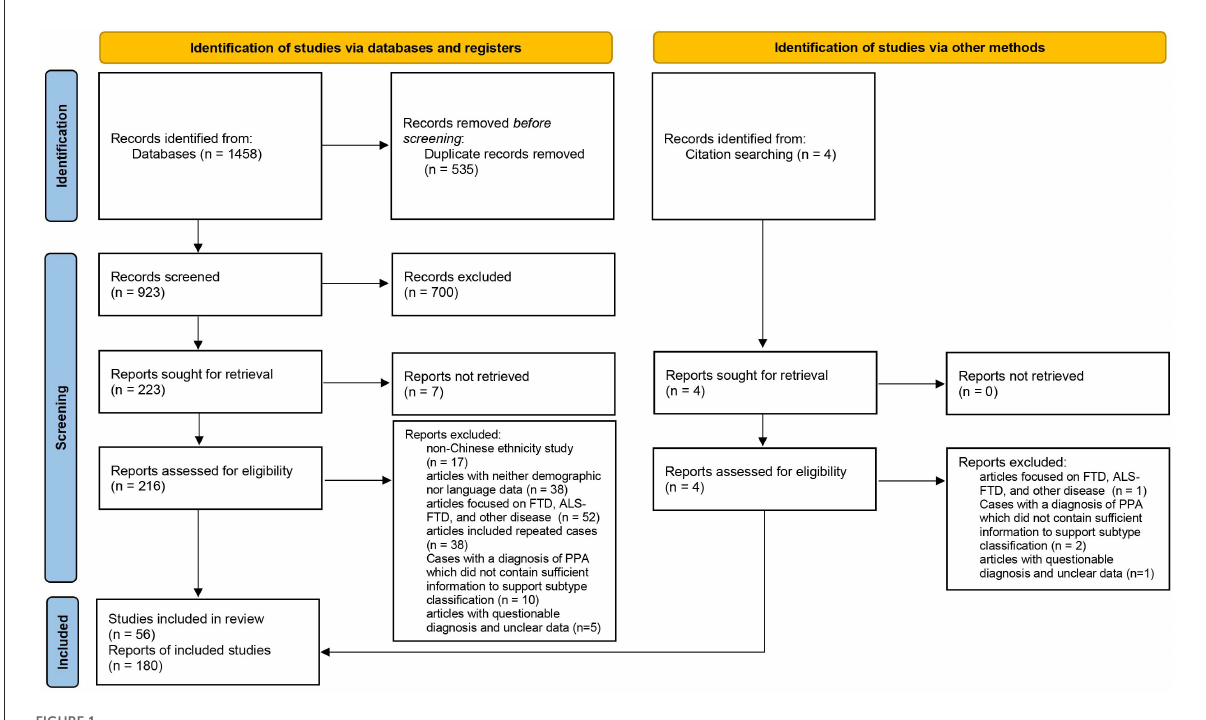
FIGURE1 PRISMA flow diagram illustrating the selection of the studies.